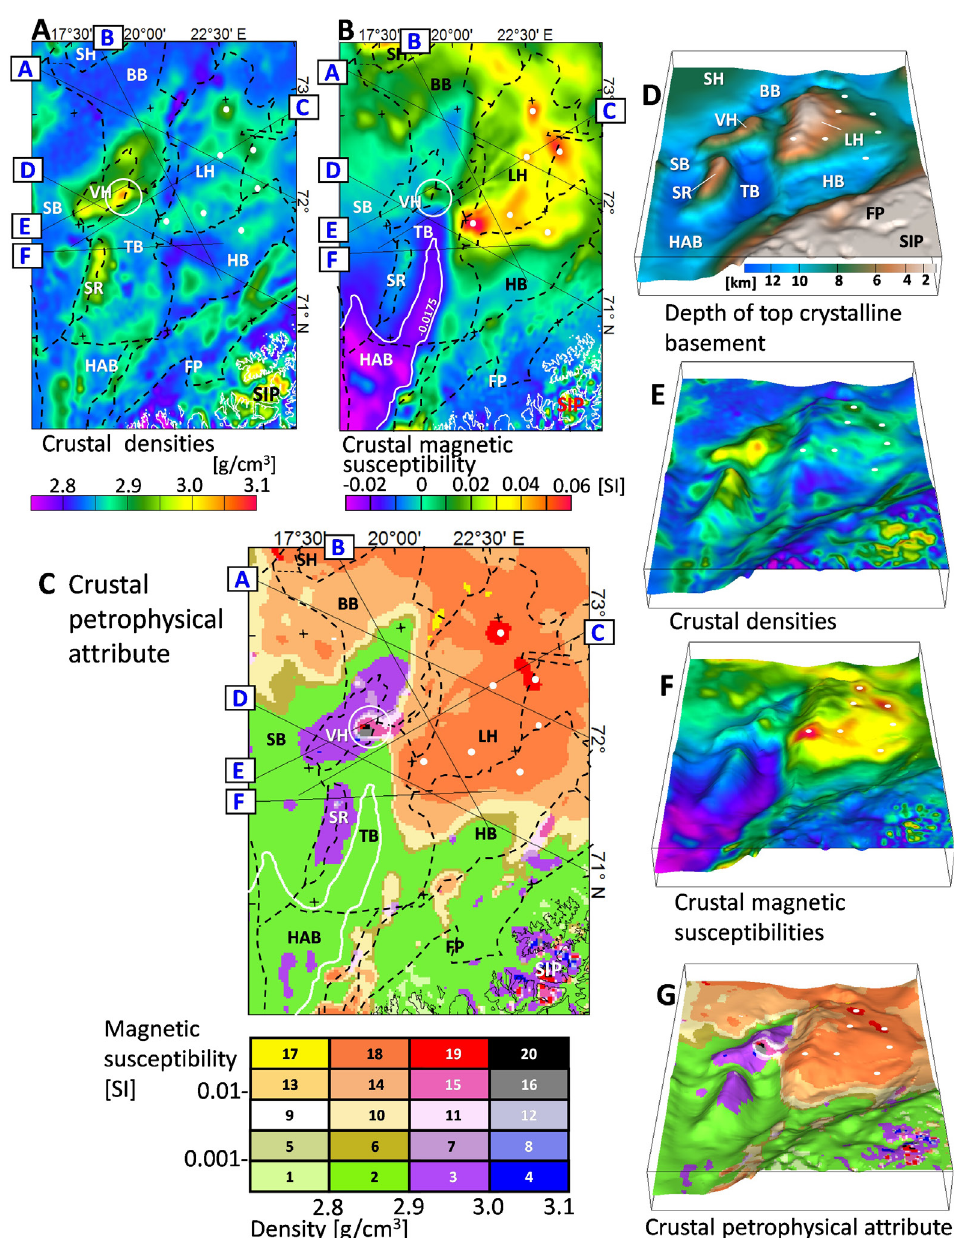
Figure 12. (A) Final model densities of the crystalline crust (crustal densities). (B) Final model magnetic susceptibilities of the crystalline crust (crustal magnetic susceptibilities) with contour at “-0.0175 SI” (white line). (C) (Crystalline) crustal petrophysical attribute with two-dimensional colour scale representing both densities and magnetic susceptibilities, colour table with colour identification code (ID), contour line (white) of susceptibility “-0.0175 SI”, seismic profile locations (black lines with blue annotation; details in Fig. 1), boundaries of structural elements (black dashed, abbreviations in Fig. 2.). (D) 3D view of the topography of the top crystalline basement coated with (E) the crustal densities, with (F) the crustal magnetic susceptibilities, and with (G) the crustal petrophysical attribute. White dots and white ring mark interpreted intrusions that are discussed in the